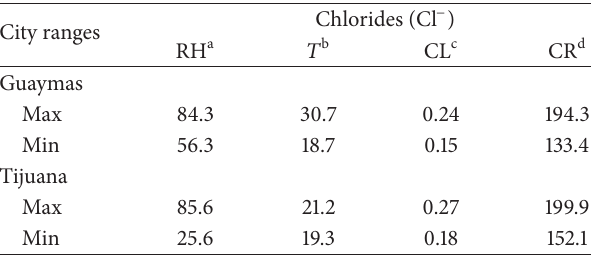
Table2:EffectofRH,temperature,andSO 𝑋 inCRofSCinthecities evaluated for one month in winter in marine regions (2011).